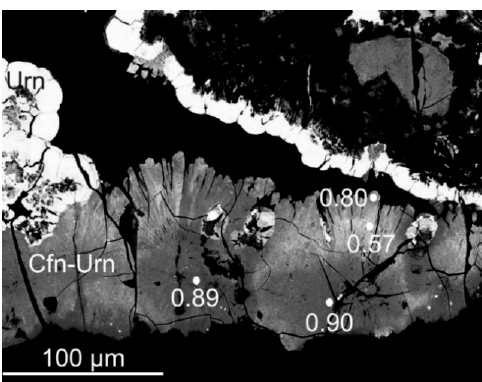
Figure 11. BSE image of coffinitized uraninite with distribution of Si ( apfu , O = 4), Zálesí uranium deposit. Urn—uraninite, Cfn-Urn—coffinitized uraninite. Table 2. Concentration ranges of selected components in coffinite.